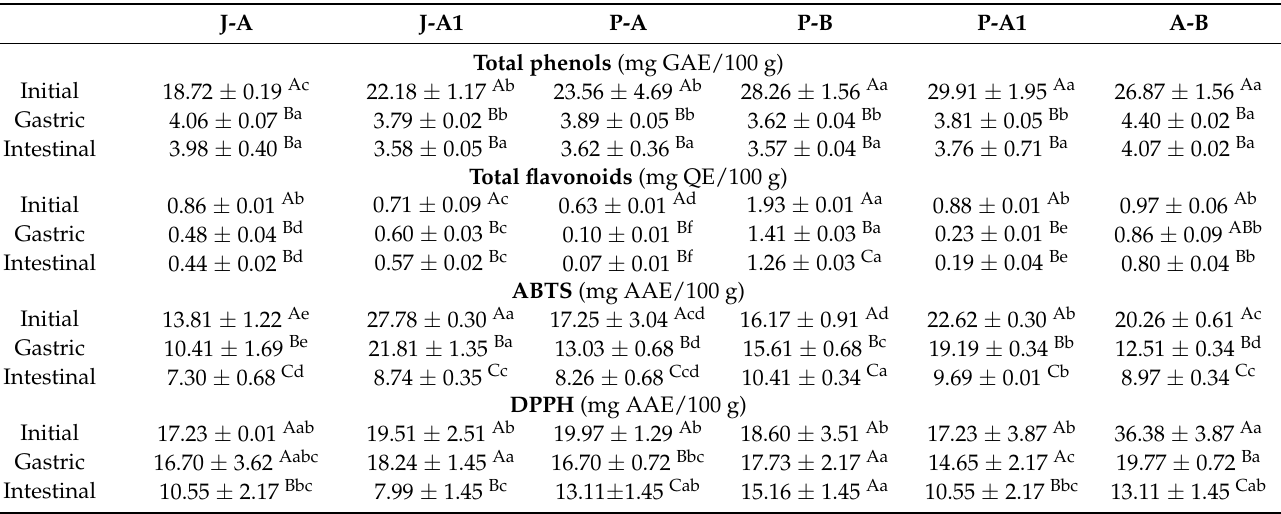
Table 2. In vitro digestibility of bioactive compounds and antioxidant activity at 20 min of ultrasound. J-A J-A1 P-A P-B P-A1 A-B Total phenols (mg GAE/100